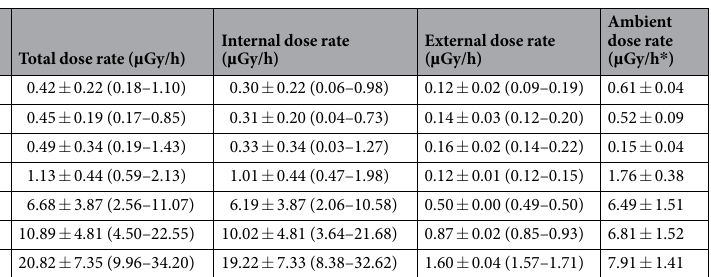
Ambient dose rate ( µ Gy/h * )